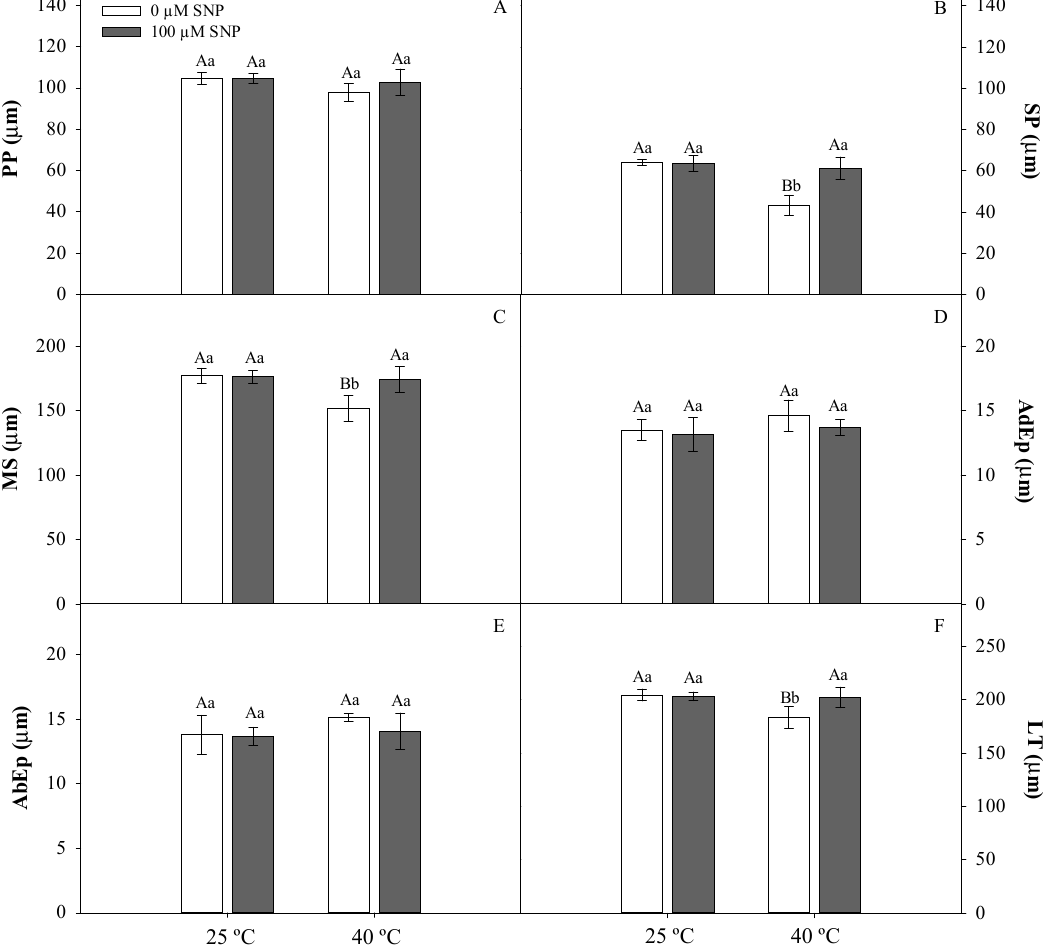
Figure 3. Palisade parenchyma (PP, A ), spongy parenchyma (SP, B ), mesophyll (MS, C ), adaxial epidermis (AdEp, D ), abaxial epidermis (AbEp, E ), and leaf thickness (LT, F ) in soybean plants submitted to two temperatures (25 °C and 40 °C) and two SNP concentrations (0 and 100 μ M). Bars represent means ( n = 5) ± SE. Capital letters (between temperatures) and lowercase letters (within temperatures) represent significant differences using Tukey’s test ( p < 0.05).